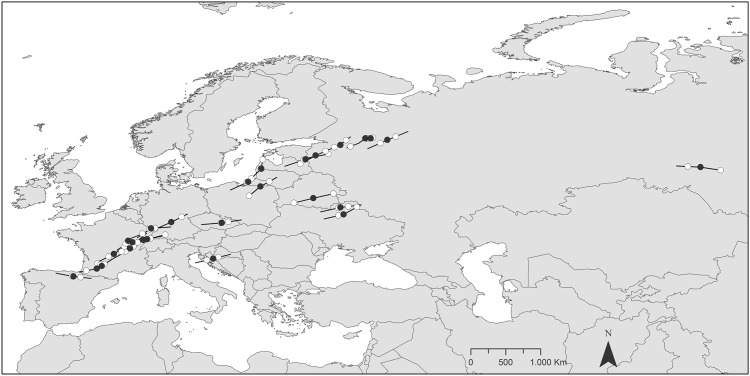
Example (replication 1) of the location of the stopover localities (closed dots) and the two randomly selected points (open dots) along the route of migration of nine woodcocks in spring.